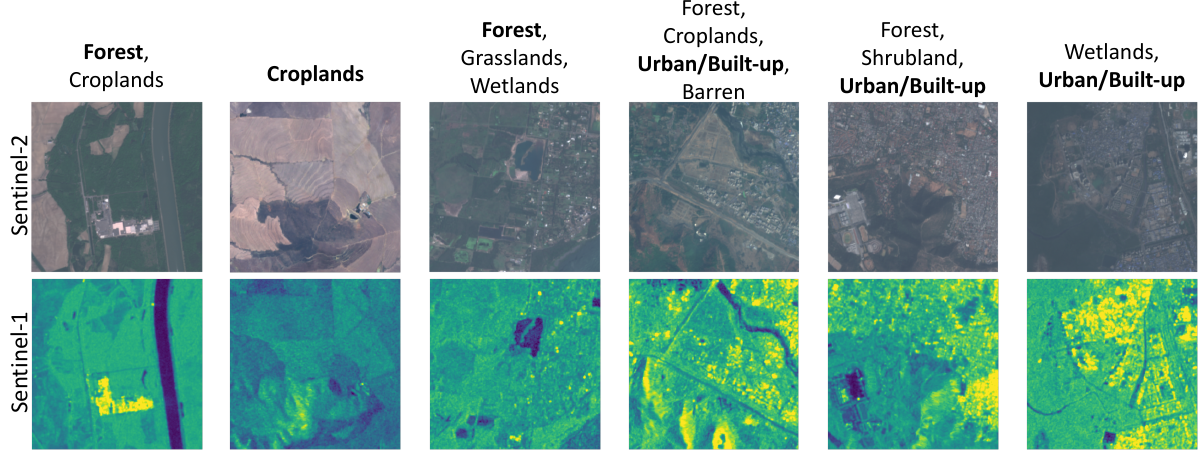
Figure 2. Sample of Sentinel-1/2 image pairs (RGB bands of Sentinel-2 and VV polarization of Sentinel-1) with multi-labels obtained from the DFC2020 dataset. The multi-label classes are given with the majority class in bold